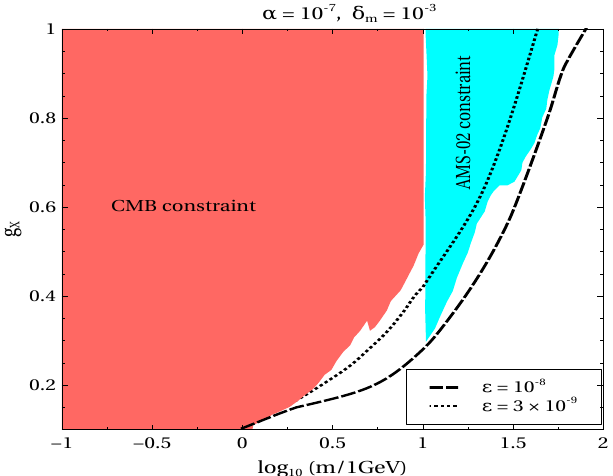
Figure 15 . CMB (red) and AMS-02 (cyan) constraints in the m − g X plane. The relic density satisfied lines are shown for (cid:15) = 10 − 8 (dashed line) and (cid:15) = 3 × 10 − 9 (dotted line). Here we have considered α = 10 − 7 and mass splitting parameter δ dashed line satisfying correct relic density is disallowed from the condition x